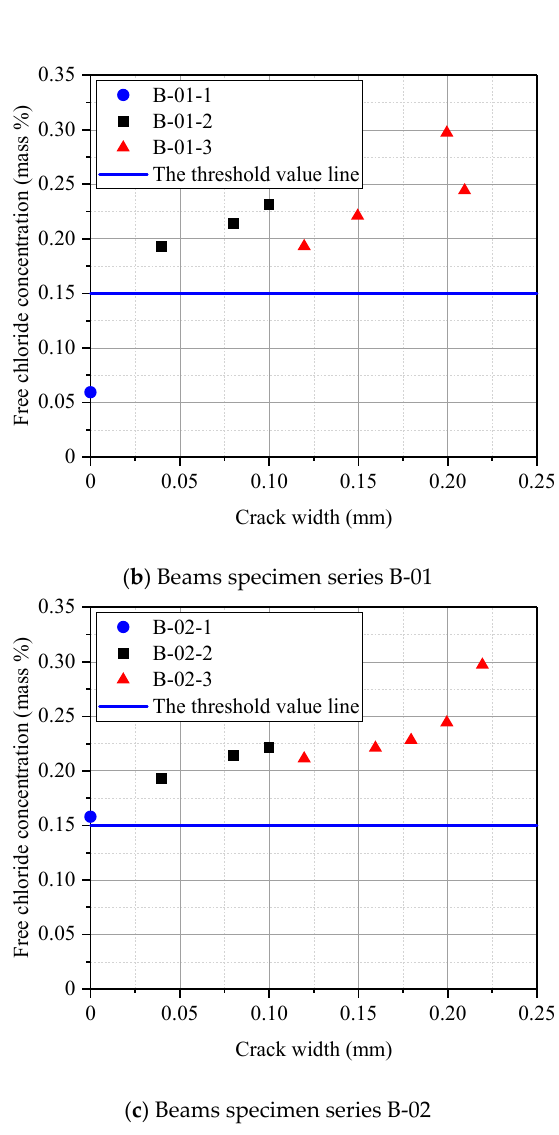
Figure 11. Free chloride profile at given depths ( x = 25 mm) in cracked concrete section. ( a ) Beams A; ( b ) Beams specimen series B-01; ( c ) Beams specimen series B-02.